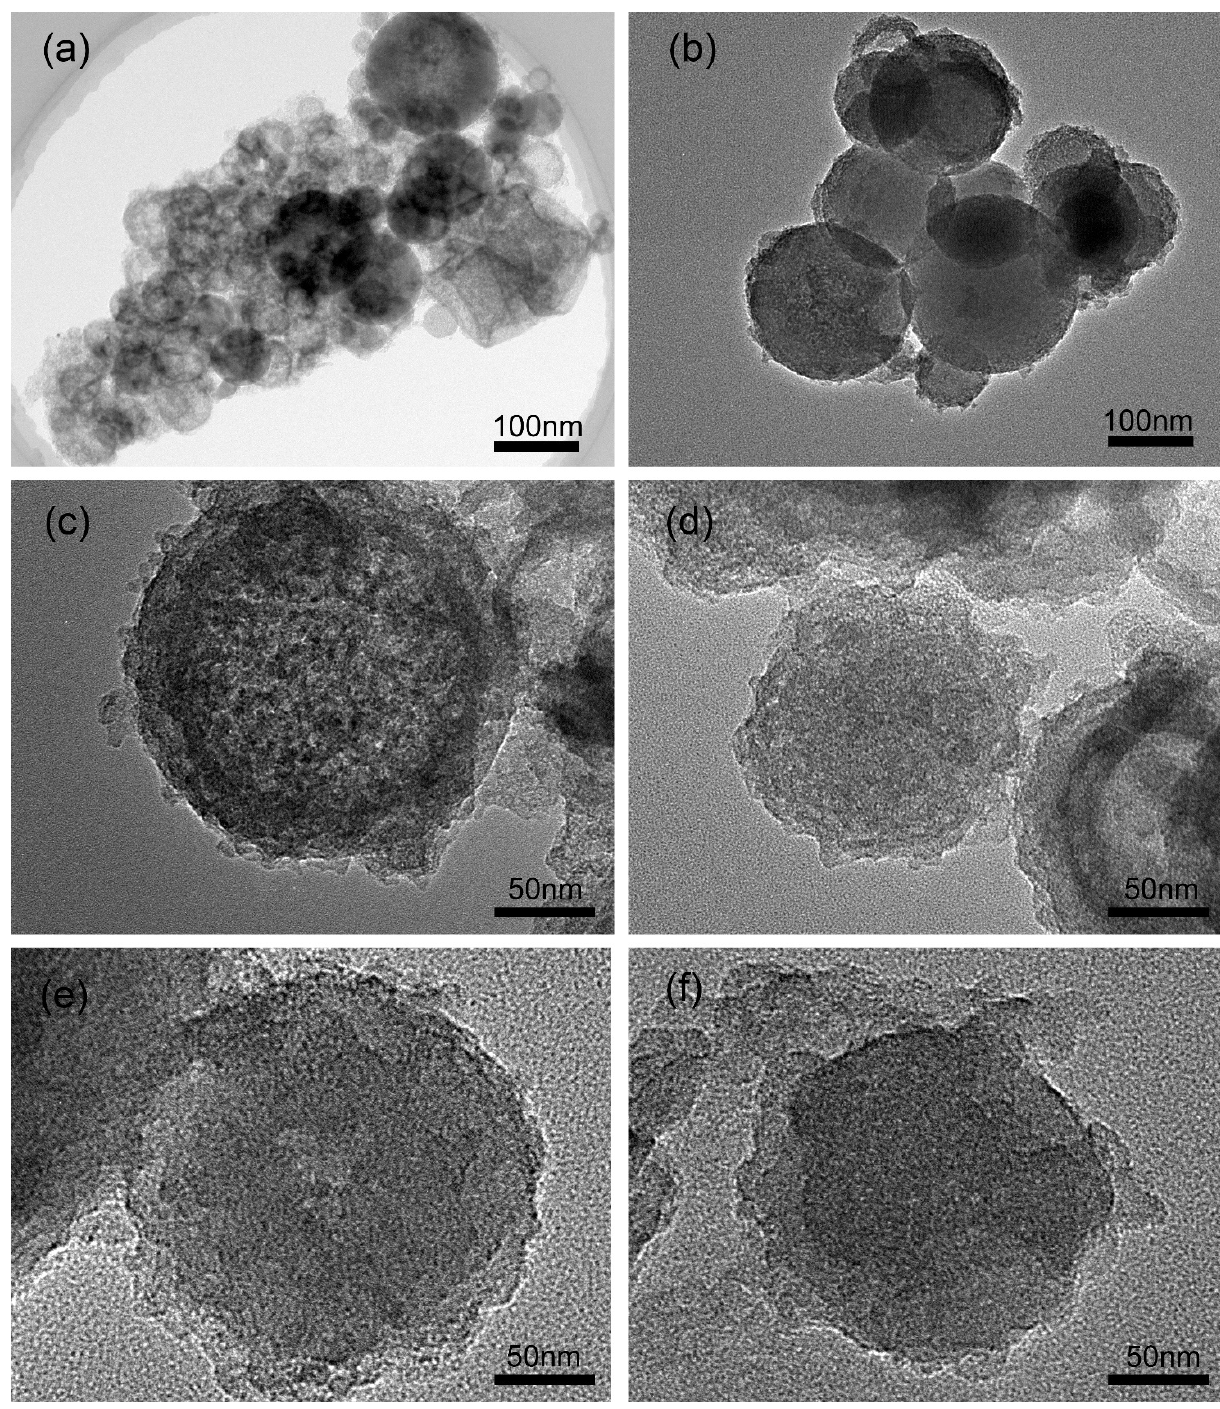
Figure 2. TEM images of ( a ) P-silica, ( b ) FS-5.3, ( c ) FS-6.3, ( d ) FS-7.3, ( e ) FS-8.3, ( f ) FS-9.3.